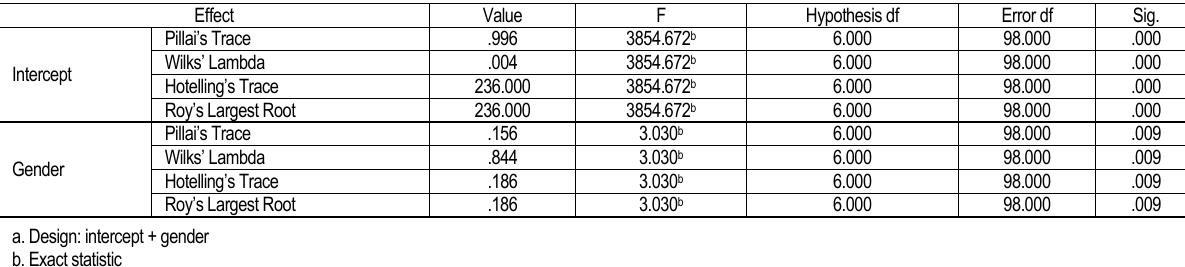
Table 7. Multivariate tests – impact factors for entrepreneurship development and